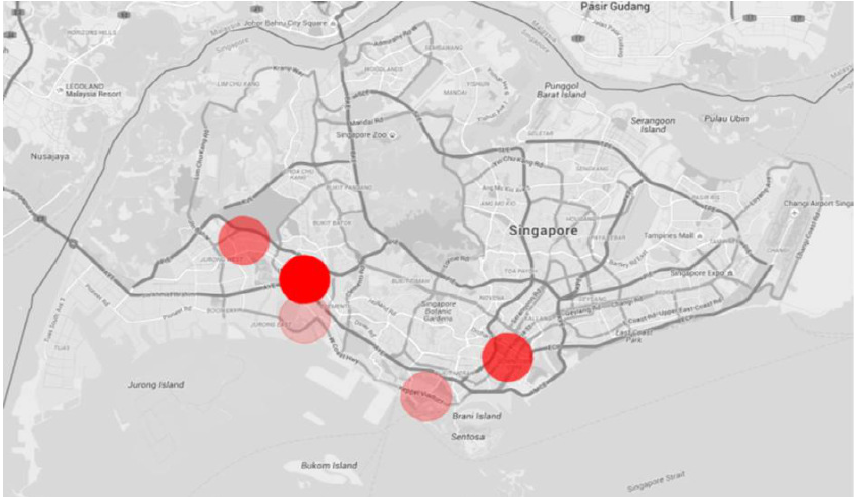
Figure 5. Top five stay regions of a